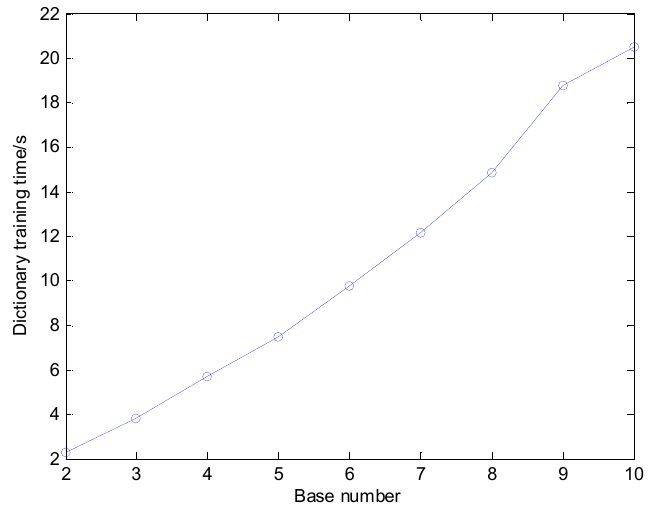
Figure 10. Dictionary training time using different K .